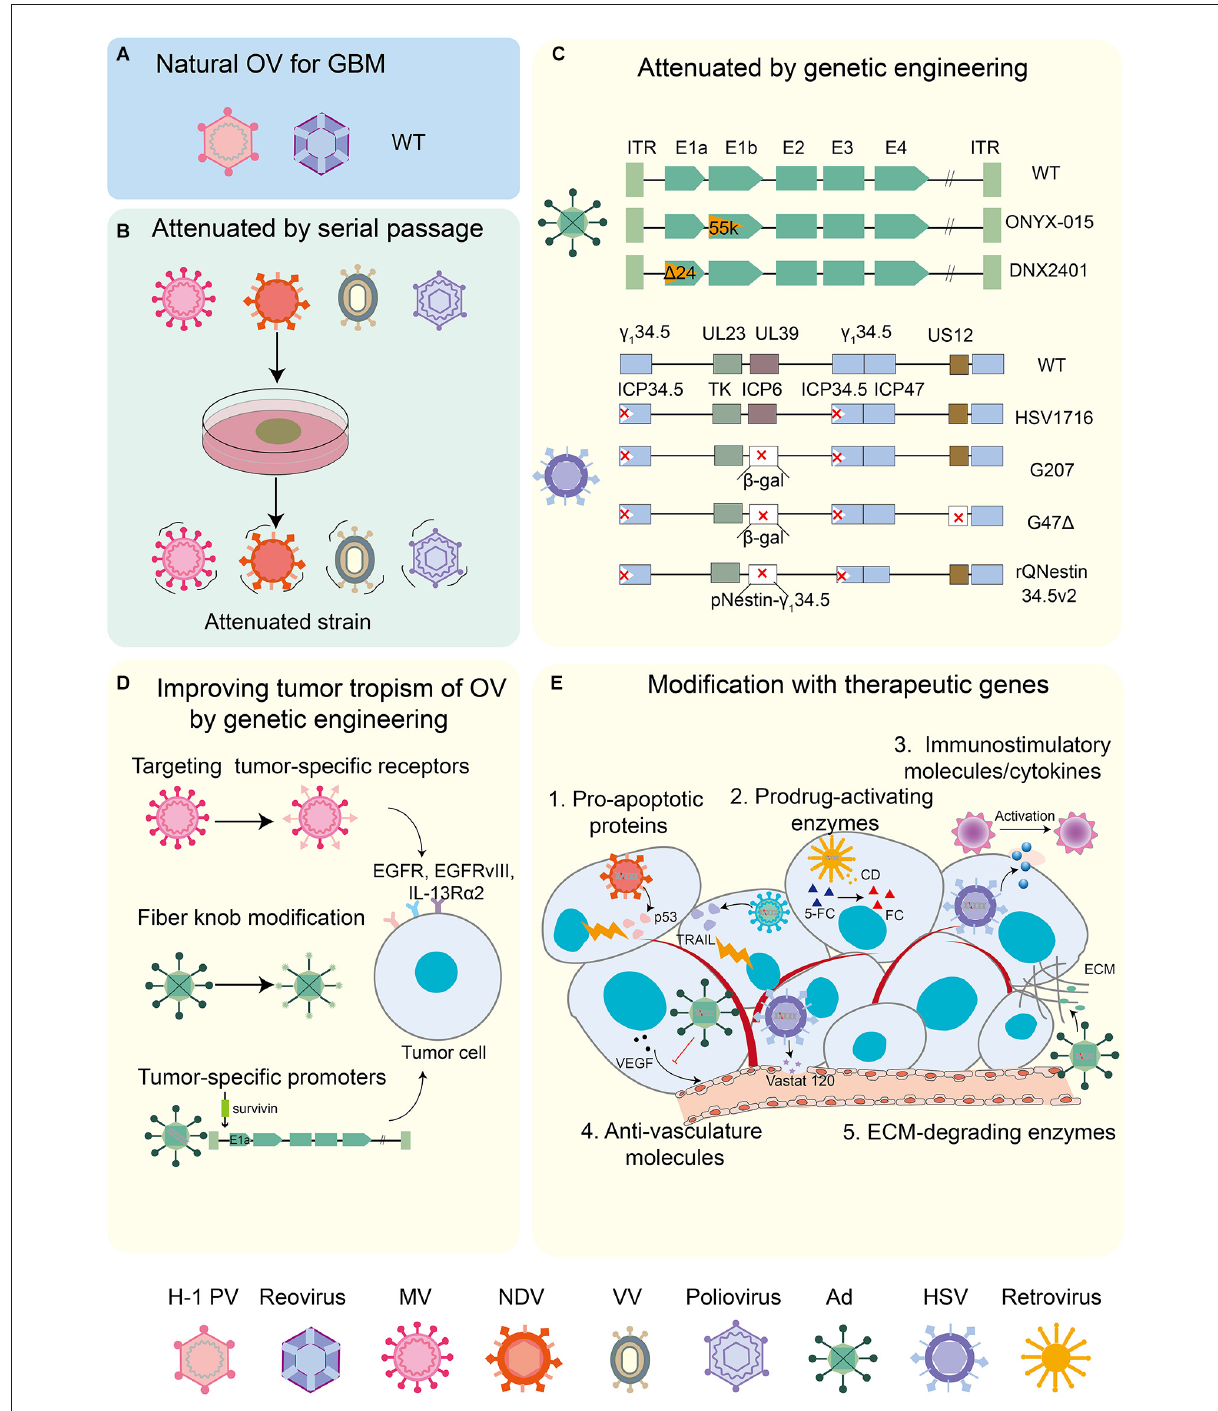
FIGURE1 OVs in GBM treatment. (A) Natural OVs for GBM. Wild-type (WT) virus strains including H1 PV and reovirus could be used directly for oncolytic virotherapy of GBM. (B) OVs attenuated by serial passaging include MV, NDV, VV, and poliovirus. (C) OVs attenuated by genetic engineering. Improving the safety of Ad and HSV by deleting virulence genes. (D) Enhanced tropism of OV via genetic engineering. MV-targeted entry into tumors is facilitated by targeting tumor-associated specific receptors (such as EGFR, EGFRvIII, and IL-13R α 2 receptor). Enhanced tumor targeting of Ad by modifying fiber knobs of viral capsid proteins (exchanging viral capsid protein fibers of different serotypes and RGD modifications). Ad replicating in tumor cells, but not in normal cells, is controlled by tumor-specific promoter sequences (such as surviving) into the genetic sequence of a virus. (E) Enhanced antitumor effects of OV by modifying with different therapeutic genes, such as pro-apoptotic proteins, conditional cytotoxic enzymes, immunomodulatory factors/cytokines, anti-angiogenic molecules, and